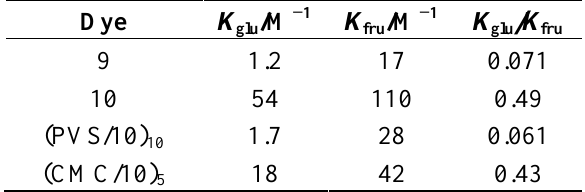
Table 2. The binding constants of dye 9 , 10 and multilayered films in 10 mM CHES buffer (pH 9.0). PVS, poly(vinyl sulfate); CMC, carboxymethylcellulose.